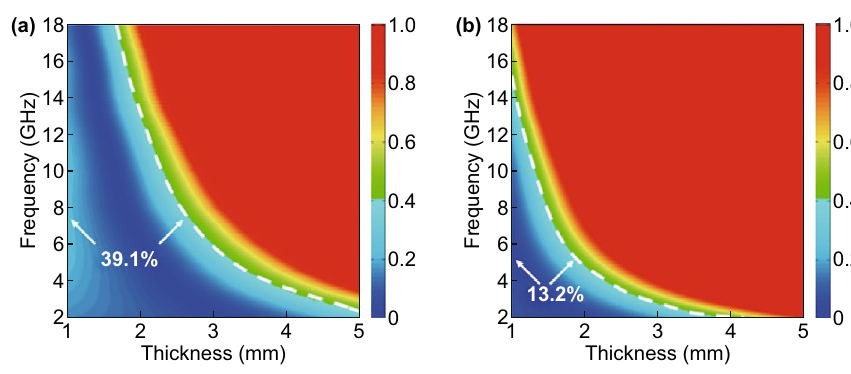
Fig. 7 Delta maps of a WCC-6 and b WCC-8 with different absorber thickness in the frequency range of 2.0–18.0